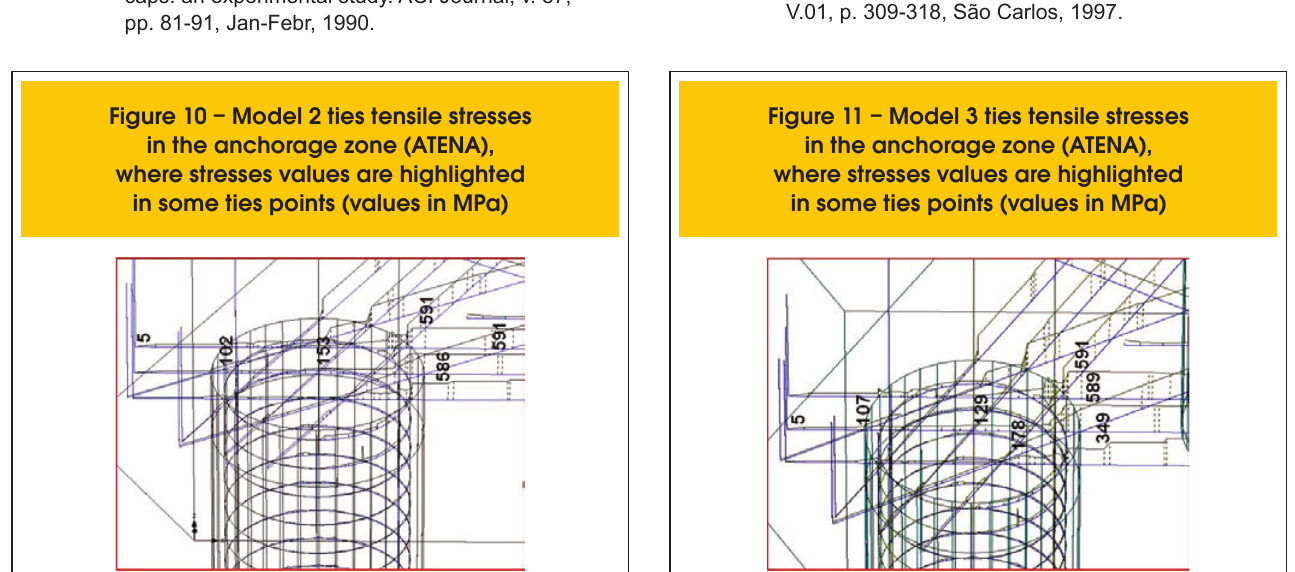
Figure 11 – Model 3 ties tensile stresses in the anchorage zone (ATENA), where stresses values are highlighted in some ties points (values in